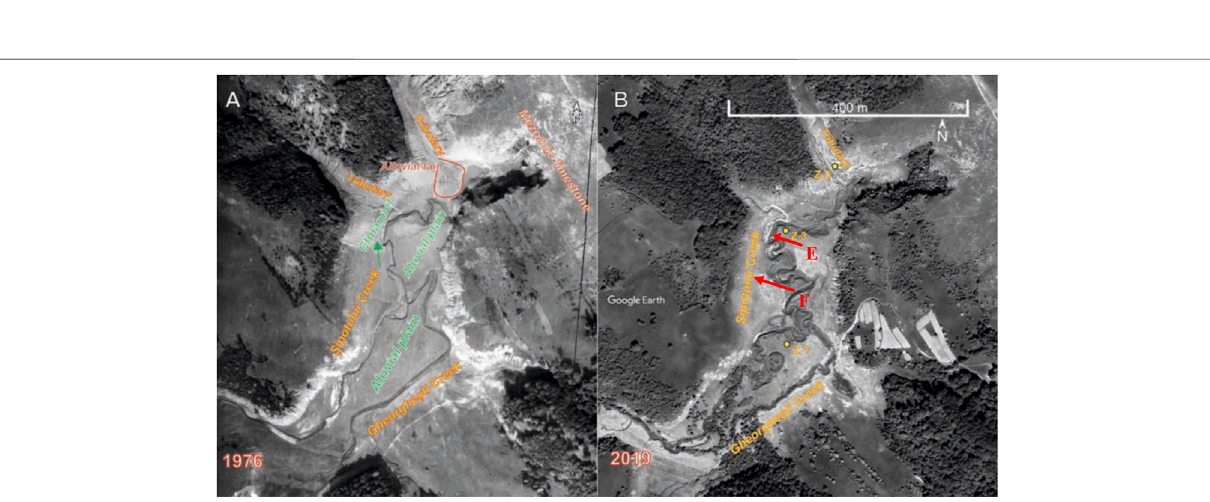
Frontiers in Earth Science |